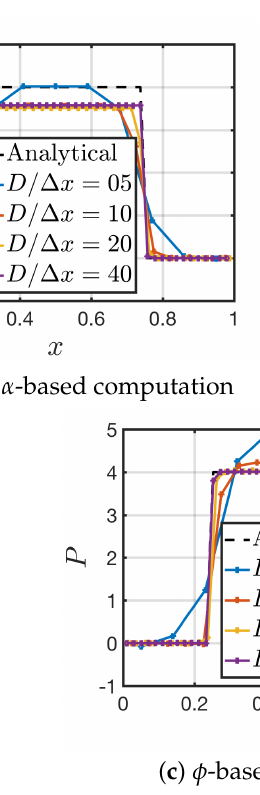
Figure 2. Pressure distribution along the centerline of a 2D droplet ( R = 0.25) is presented at four different grid resolutions corresponding to the three curvature